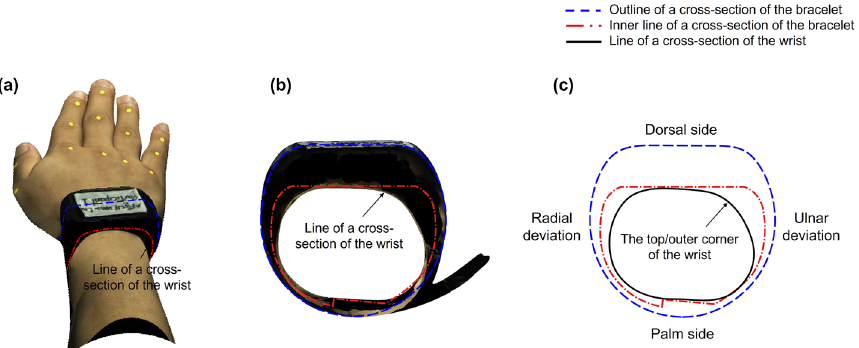
Fig. 4 Cross‑sectional view of the wrist and bracelet: ( a ) 3D shape of an electronic bracelet worn on the